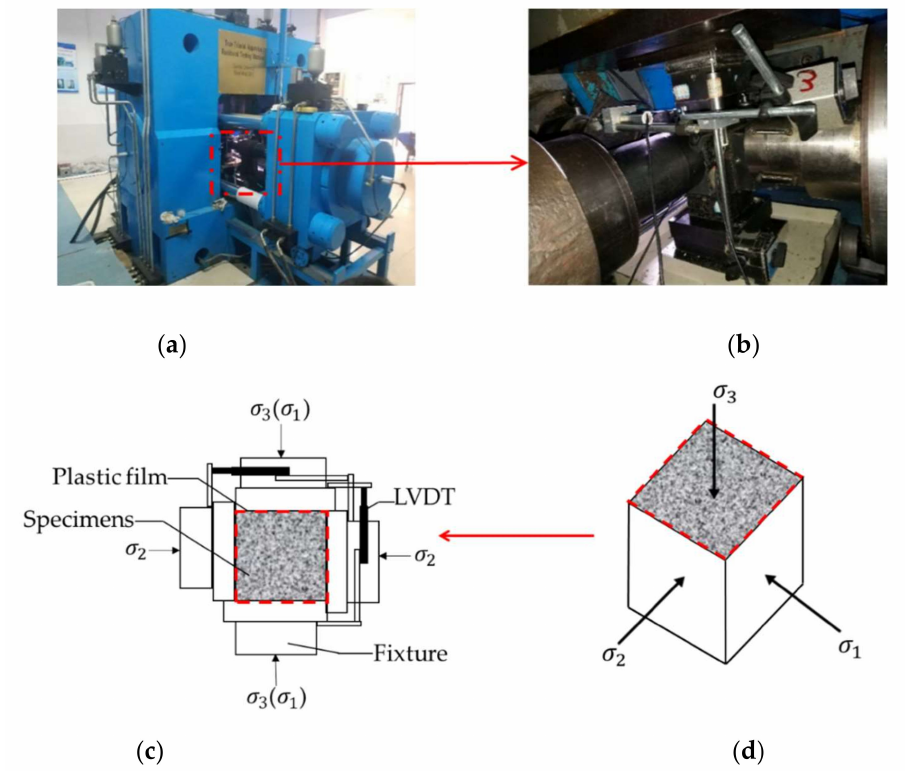
Figure 2. Triaxial loading setup: ( a ) the exterior of the setup; ( b ) the interior of the setup; ( c ) the loading schematic of the specimen; ( d ) the loading direction of the